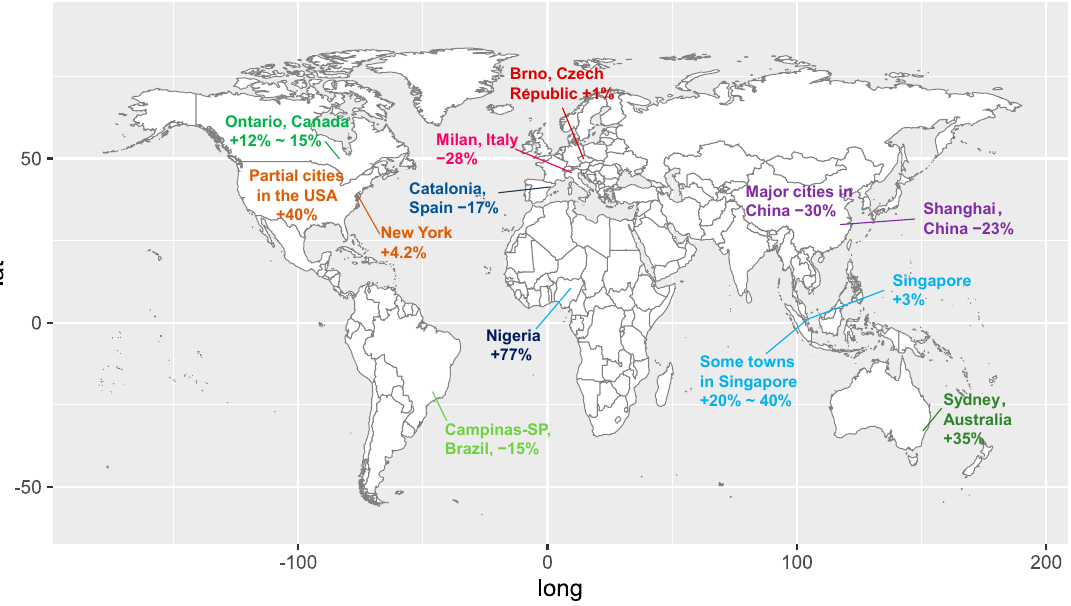
Figure 3. The spatial heterogeneity of the change rate of solid waste generation caused by COVID-19.